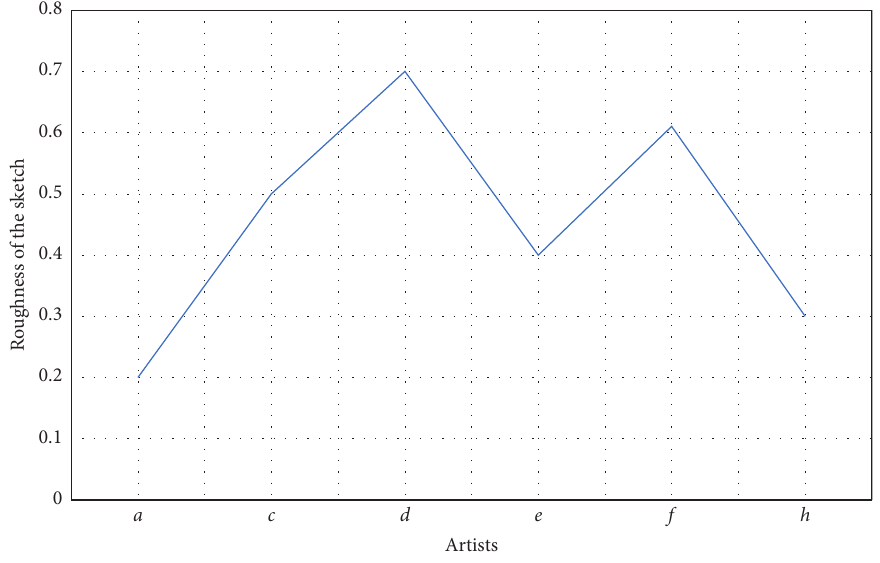
Figure 2: A graphical interpretation of Table 2. Table 3: Performance of the artists after the second phase. Artists Performance of the